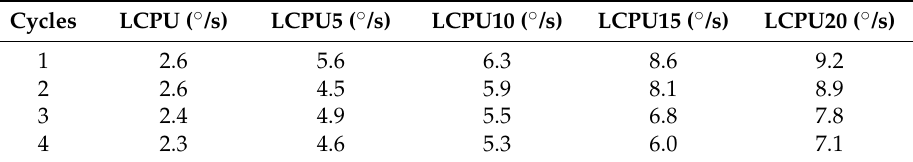
Table 3. Average shape recovery rate of all the